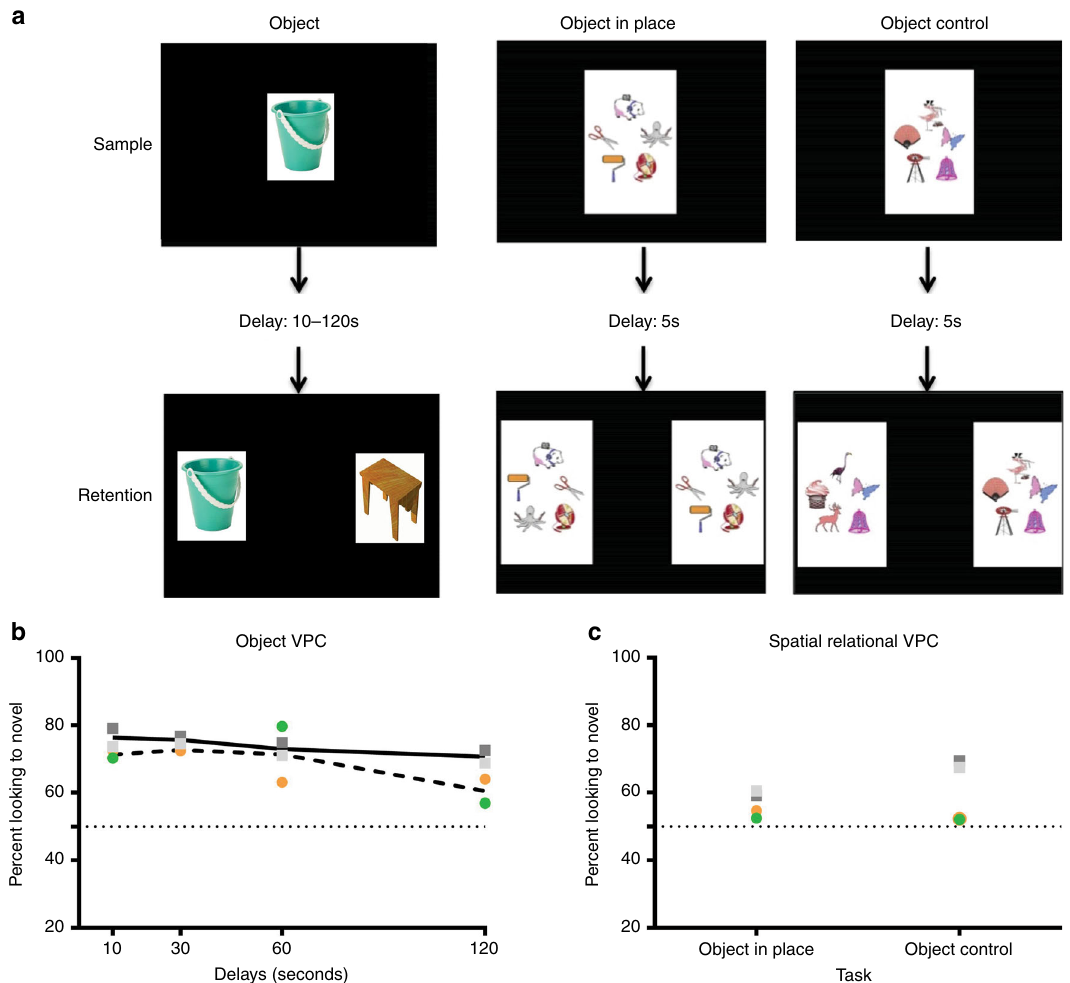
Fig. 2 Impaired visual recognition memory after postnatal ZIKV infection of infant RMs. a Illustrates an example trial for each of the three visual paired comparison (VPC) tasks used in this study. b Illustrates the percent looking toward the novel stimulus across delays for ZIKV-infected infant RMs (dashed line with circles; green = ZIKV-5 and orange = ZIKV-6) and controls (solid line with squares; dark gray = Control-1 and light gray = Control-2). c Compares the percent looking to novelty during object in place versus object control trials. Chance performance is depicted by a dotted line at infants at 3 and 6 months of age 31 , groups did not differ in GM or WM volumes at 12 months of age, which implies potential neural recovery after postnatal ZIKV insult.